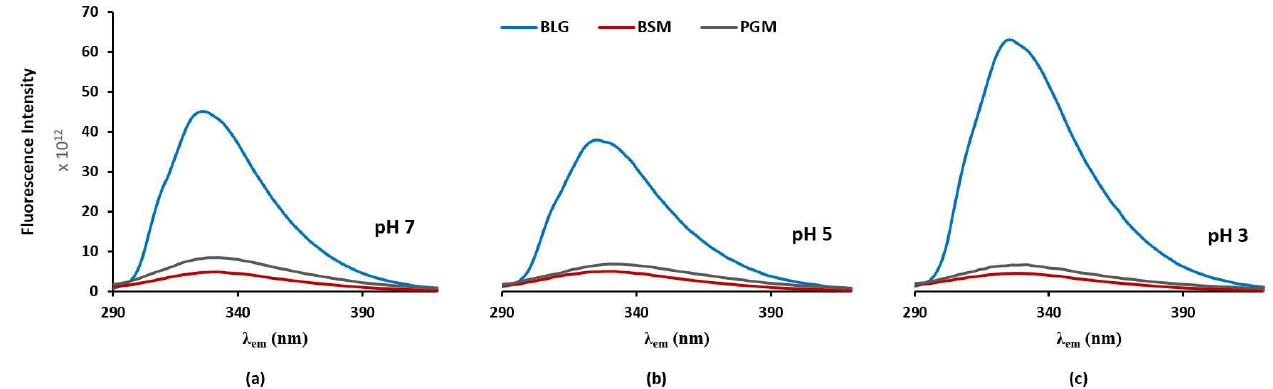
Figure 1. Fluorescence emission spectra (at λ ex 280 nm) of β-lactoglobulin (BLG), bovine submaxillary mucin (BSM), and porcine gastric mucin (PGM) at the same concentration (0.5 mg/mL) in different pH values of phosphate buffer solutions (( a ) pH 7, ( b ) pH 5, and ( c ) pH 3).